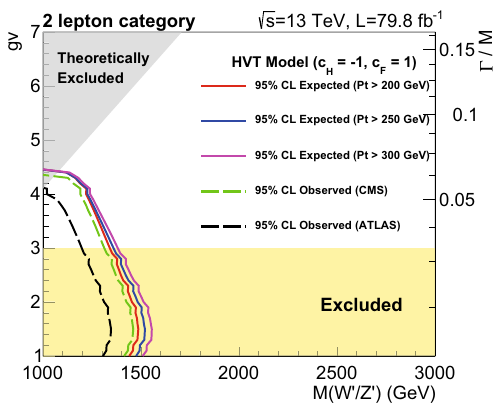
Fig. 15 Expected 95% CL HVT limits as a function of the reso- nance mass and width, for an integrated luminosity of 79 . 8 fb − 1 . The limits for the 2-lepton category are shown for increasing p ⊥ > 200 , 250 , 300 GeV selections. Estimated observed limits by ATLAS and CMS are also shown. The theoretically excluded regions corre- spond to regions of small physical mass and large g V coupling, where the HVT model cannot reproduce the SM input parameters α EW , G F and M